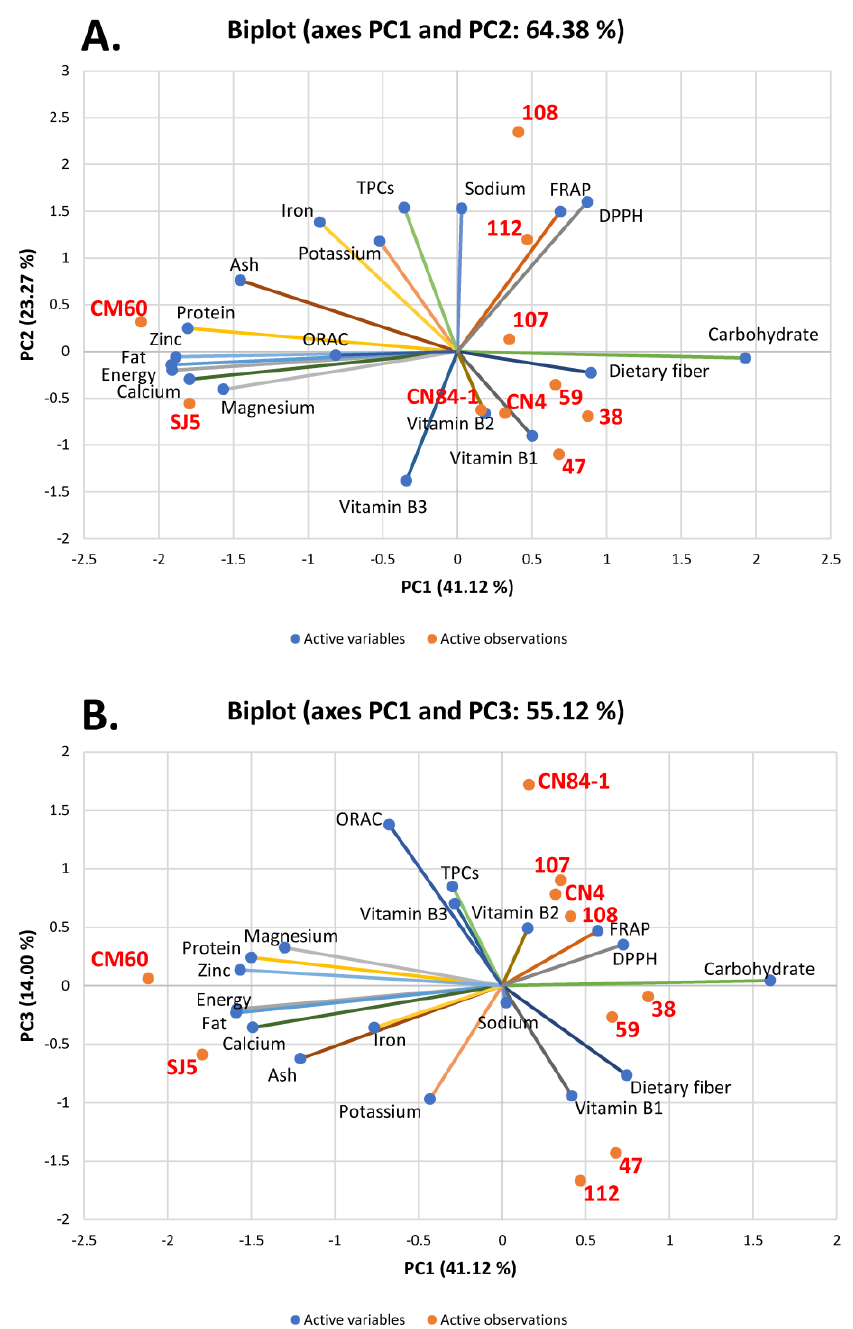
Figure 2. The biplot derived from principal component analysis (PCA). The mean values of (proximate compositions, vitamins, and minerals), total phenolic contents (TPCs), and antioxidant activities as being determined by oxygen radical absorbance capacity (ORAC), ferric ion reducing antioxidant power (FRAP), and 2,2-diphenyl-1-picrylhydrazyl (DPPH) radical scavenging assays of all ten bean cultivars were analyzed. ( A ) The plot between PC1 and PC2; ( B ) the plot between PC1 and